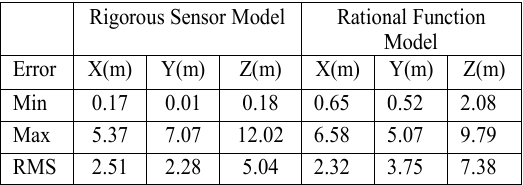
Table 1. RMSE after adjustment through RSM and RFM